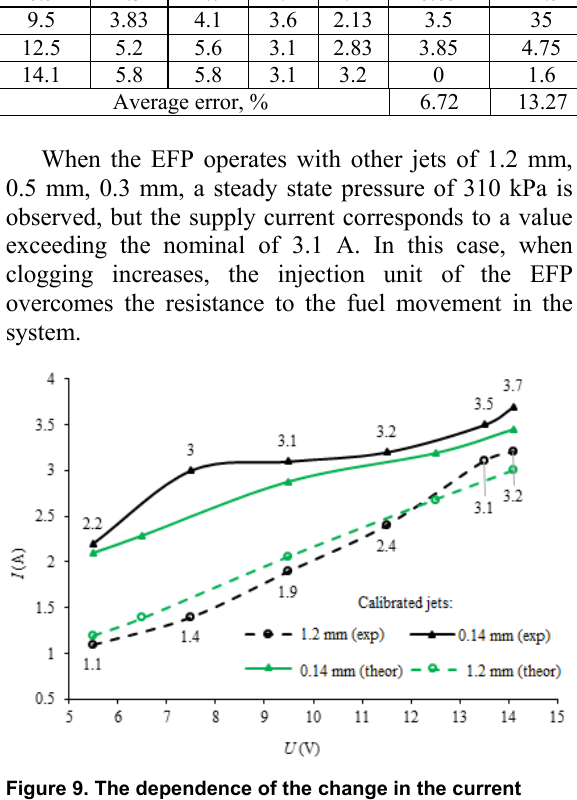
Figure 10. The dependence of the change in the pressure in the supply system on the voltage supplied to the EFP when using calibrated flow passage jets (0.14 mm...1.2 mm) connected in parallel to the fuel supply